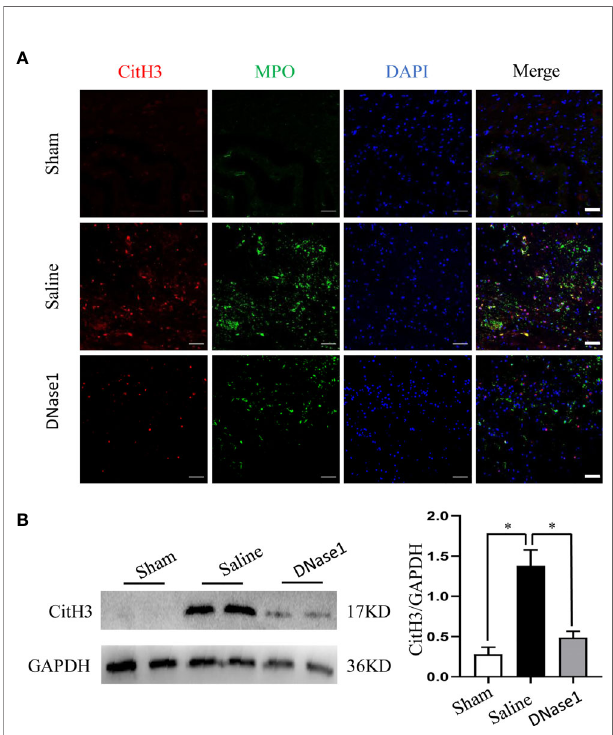
FIGURE 2 | PAD4 inhibitor (Cl-amidine) prevents NETs formation after SCI. (A) Representative images of CitH3 (red) and MPO (green) double-positive cells in spinal cord from each group at 24 h after operation. Nuclear was marked with DAPI (blue). Scale bars = 50 m m. (B) Representative immunoblots and quanti fi cation of the CitH3 levels in spinal cord of each group. GAPDH is used as a loading control. Data are presented as means ± SD of n = 9 (* p < 0.05).